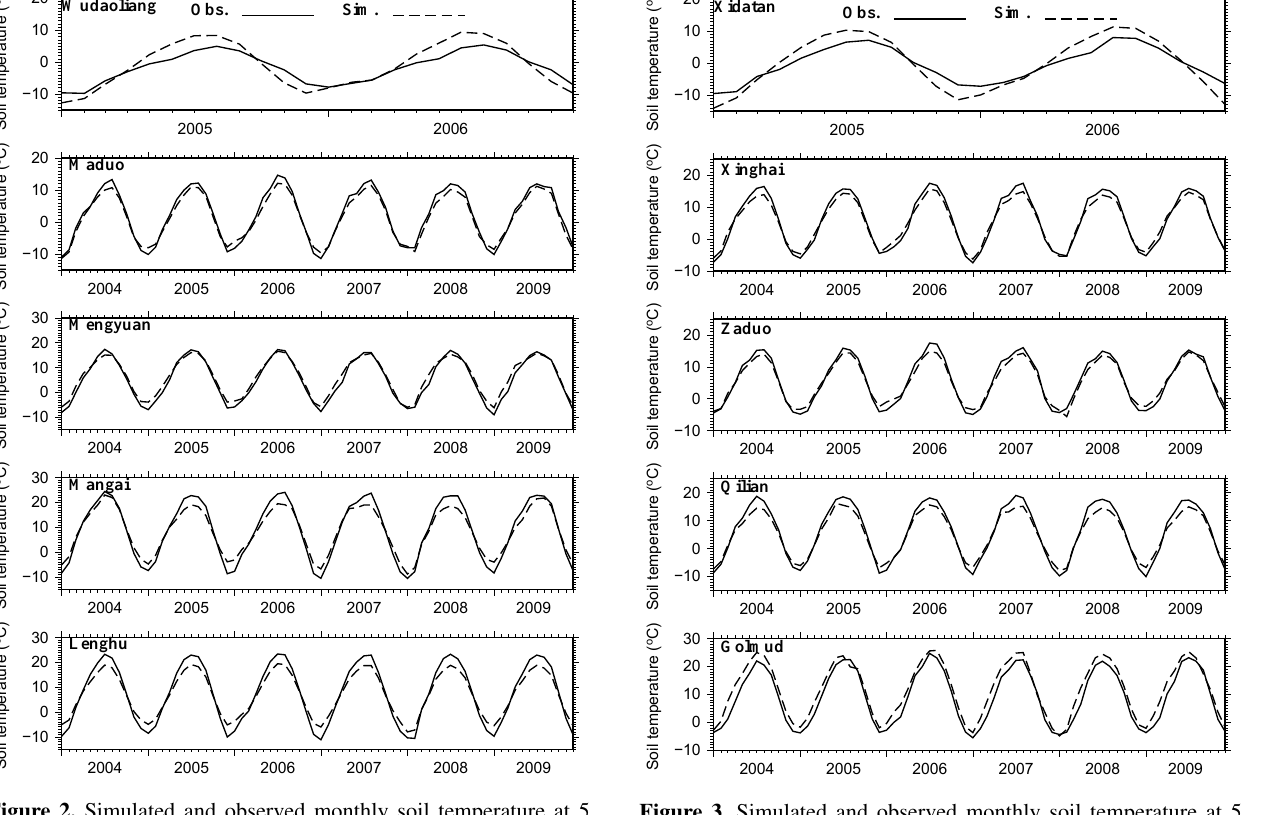
Figure 3. Simulated and observed monthly soil temperature at 5 evaluation